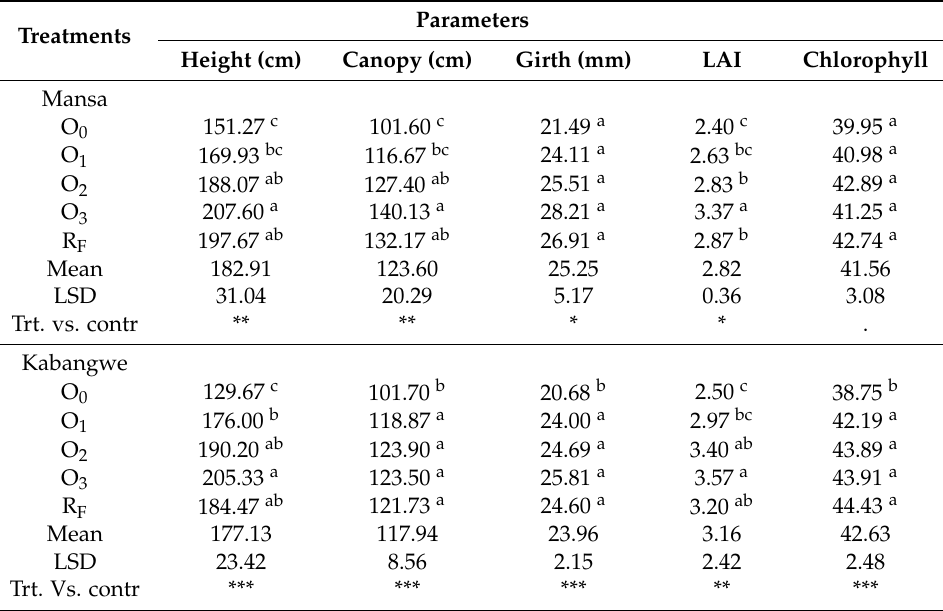
Table 4. Means of the effect of treatments on cassava growth parameters at the two sites. Parameters Treatments Height (cm) Canopy (cm) Girth (mm) LAI